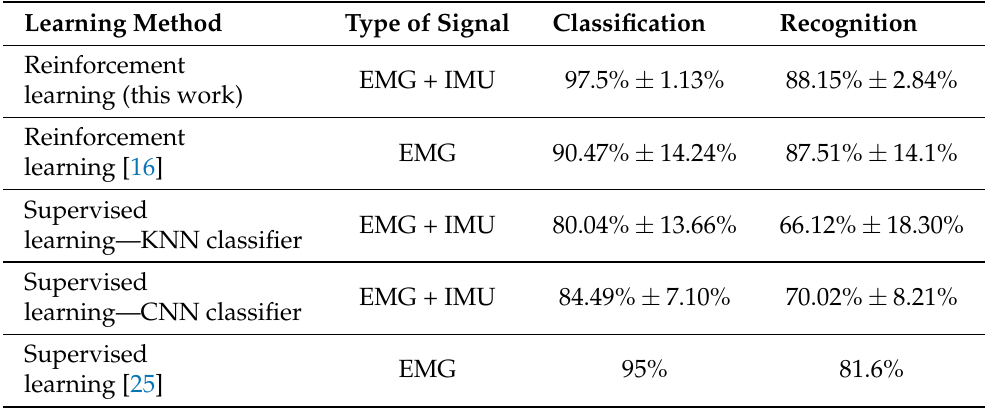
Table 5. Comparison of classification and recognition accuracy results on the test set of the proposed model compared with other